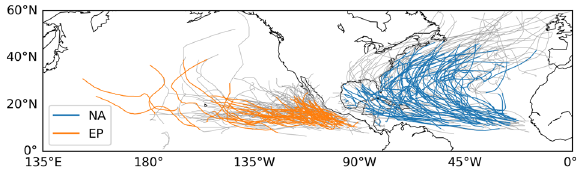
Fig. 6 TC tracks. Best track of NA and EP TCs for 2004 – 2017 before (gray tracks) and after (color tracks) data fi